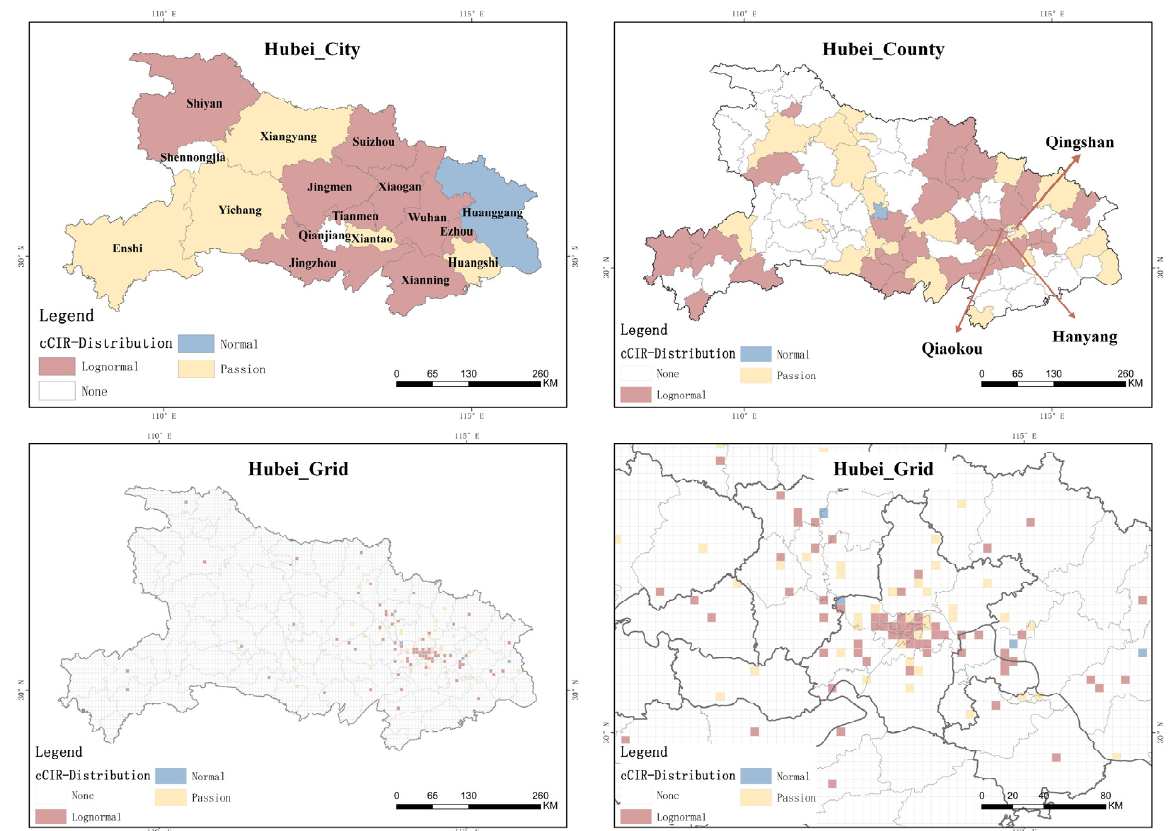
Figure 4. Fitting statistics of the spatial distribution of HCWs CIR at multiple